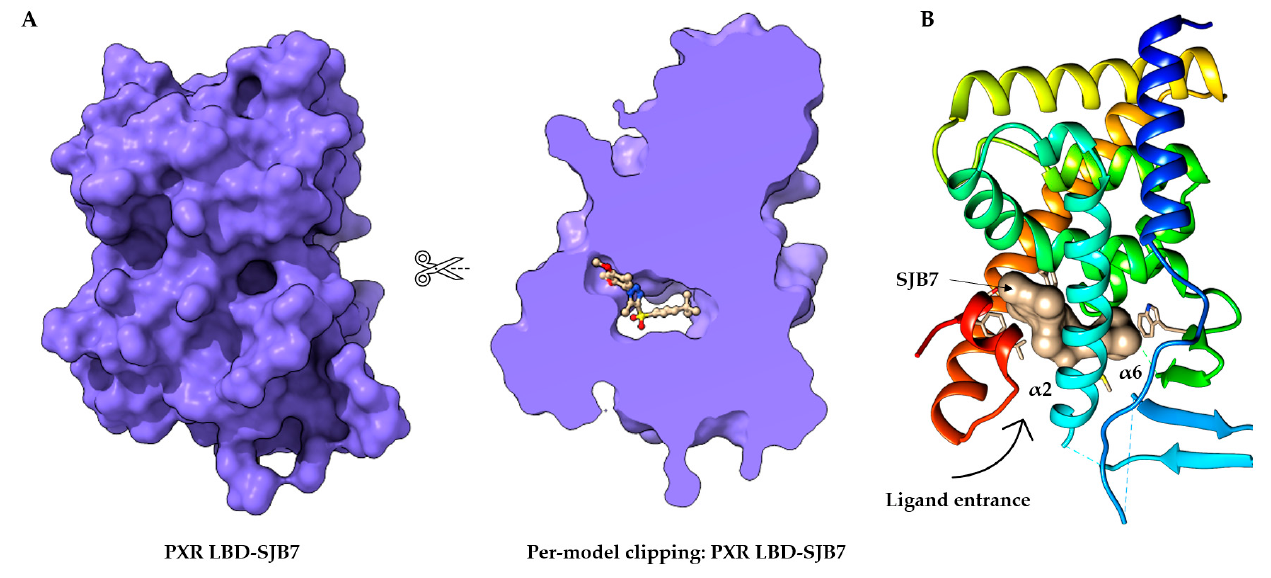
Figure 2. Structure of the orthosteric PXR ligand binding site. ( A ) Per-model clipping of the PXR ligand binding domain (to visualize invisible portions of a model). The PXR in PDB entry 5X0R has an SJB7 agonist ligand in an interior pocket, visualized using UCSF ChimeraX [41,52]. ( B ) The crystal structure of the PXR LBD complexed with SJB7. Cartoon representation of PXR- SJB7 binding in the orthosteric site. The PXR agonist SJB7 is indicated in brown, with the arrow indicating the entrance of the ligand. All structures are shown in the same orientation [41,44] .